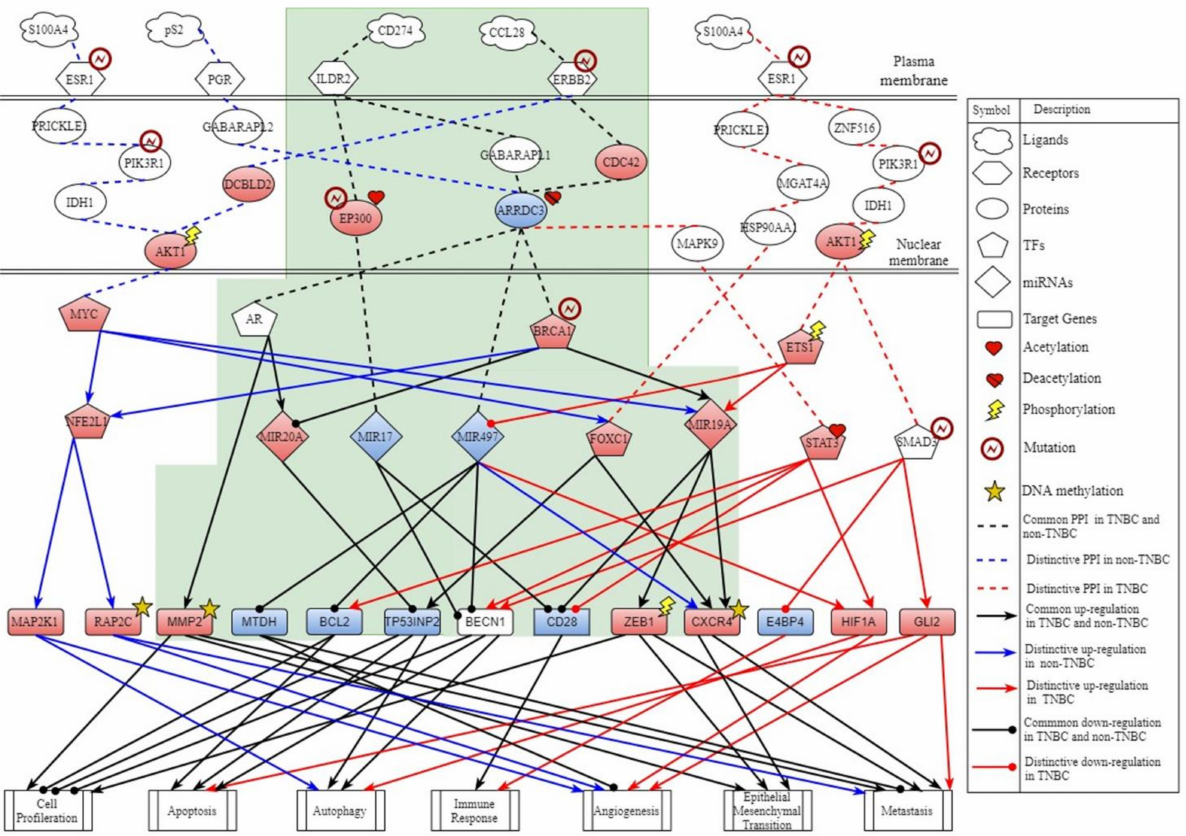
Figure 5. The common and distinctive core signaling pathways between triple negative breast cancer (TNBC) and non-triple negative breast cancer (non-TNBC). This figure summarizes the genetic and epigenetic progression mechanism of TNBC and non-TNBC. The core signaling pathways with the green background are the common core signaling pathways of TNBC and non-TNBC. The blue line indicates distinctive core signaling pathway of non-TNBC; the red line indicates distinctive core signaling pathway of TNBC; the black line indicates common core signaling pathway of TNBC and non-TNBC; the black arrow head of solid line means activation of cellular function; the black circle head of solid line means inhibition of cellular function; the red node indicates high expression of protein, receptor, TF, miRNA, and target gene; and the blue node indicates low expression of protein, receptor, TF, miRNA, and target